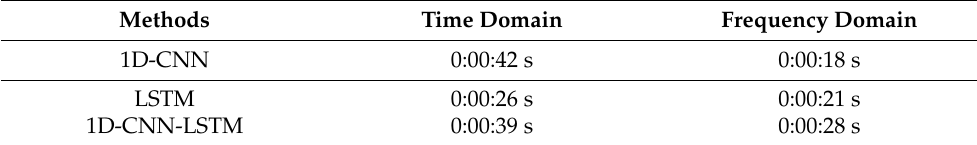
Table 15. The calculation times of the methods in the time and frequency